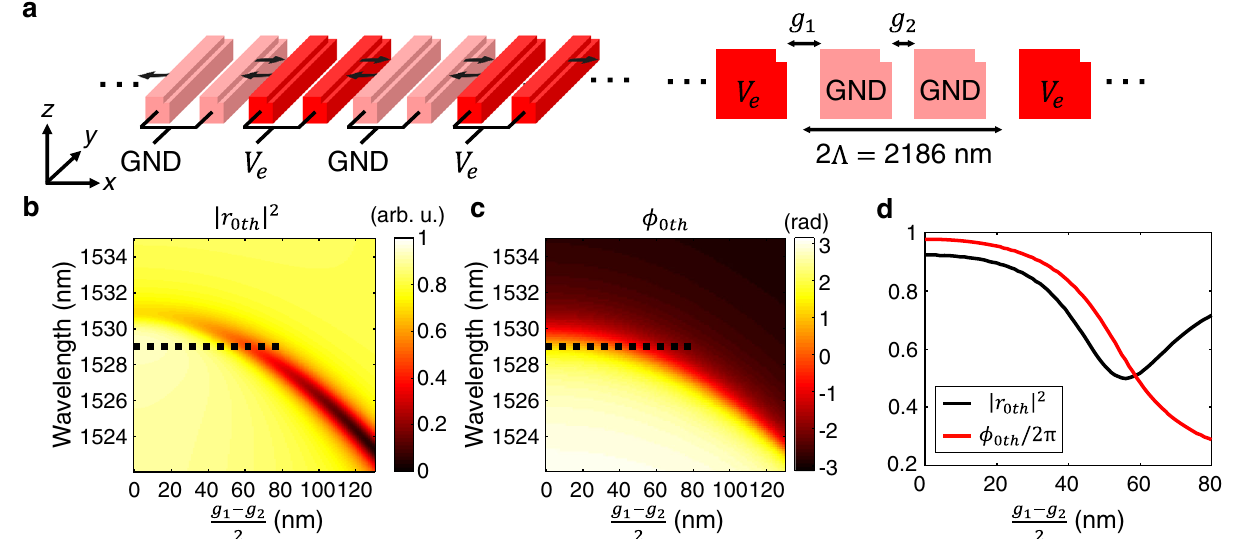
Fig. 2 | Simulations onnano-electromechanicalphasemodulation. a Schematic illustrations of an array of pairs of the asymmetric nanostructures. For every two pairs, one pair is connected to ground (GND, pink)and the other pair isconnected to an external bias ( V e , red). Left: when the external bias is applied, induced elec- trostatic forces result in lateral movements (see black arrows). Right: side view of the asymmetric metasurfaces is shown with design parameter de fi nitions.